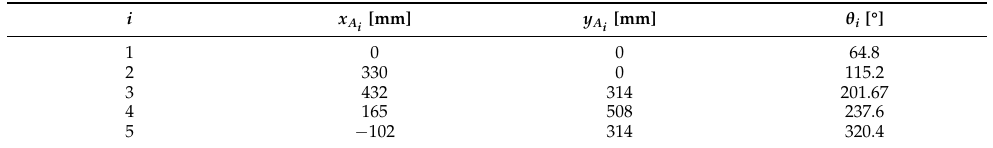
Table 7. Coordinates of the ground joints (points A i ) and the corresponding input angles θ i ; the links’ lengths are c i = 160mm, d i = 120mm and l i = 80mm (for i = 1, . . . ,5).